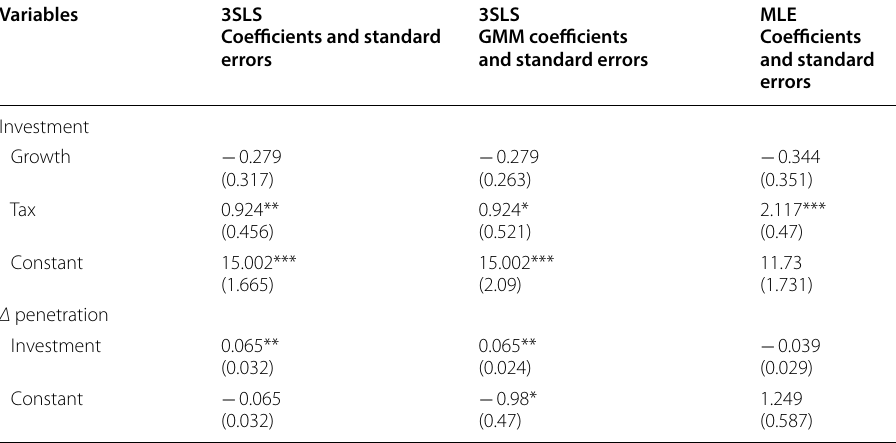
Table 6 3SLS, 3SLS GMM and MLE method (supply and infrastructure production